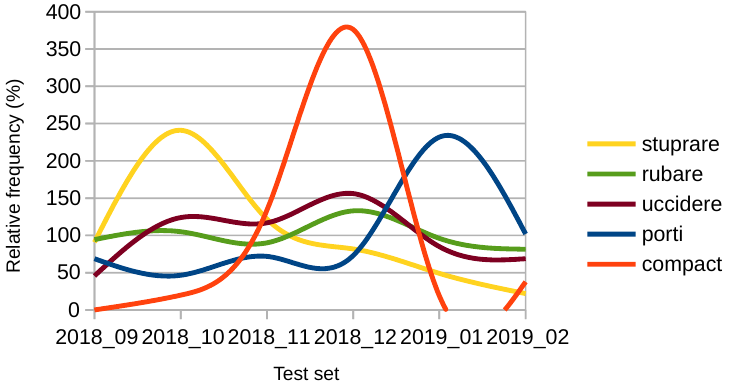
Figure 4. Relative frequencies of topical words and lemmas over